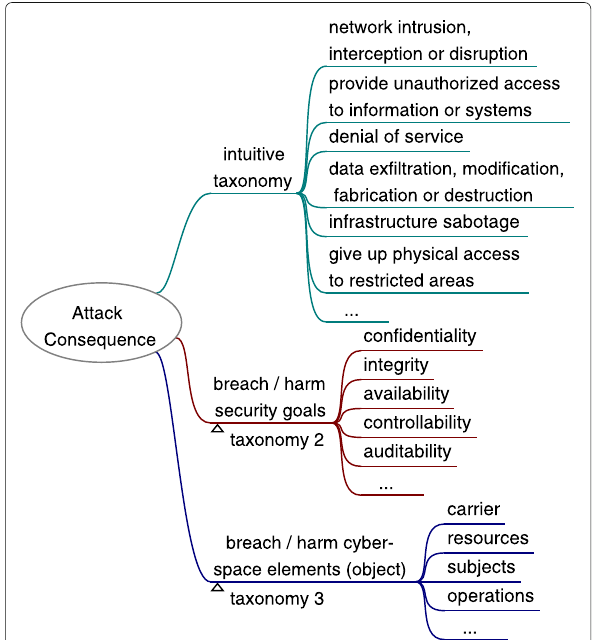
Fig. 13 Taxonomy of social engineering attack consequence